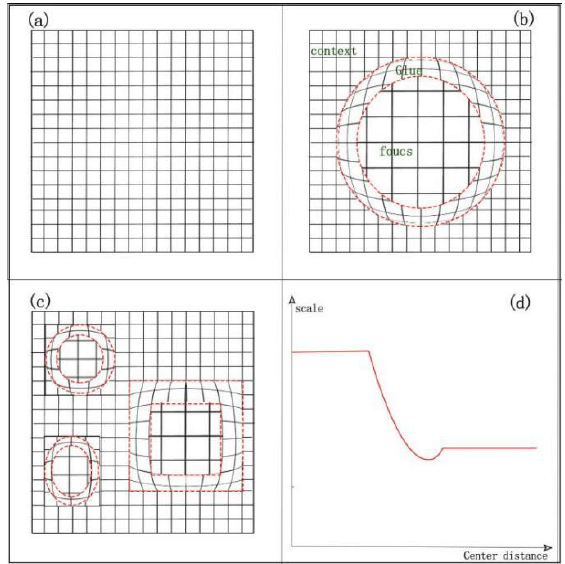
Figure 11. Variable-scale models. ( a ) Original base drawing. ( b ) F + G + C variable-scale model. ( c ) Adaptive variable-scale model. ( d ) Scale change curve of F + G + C model.